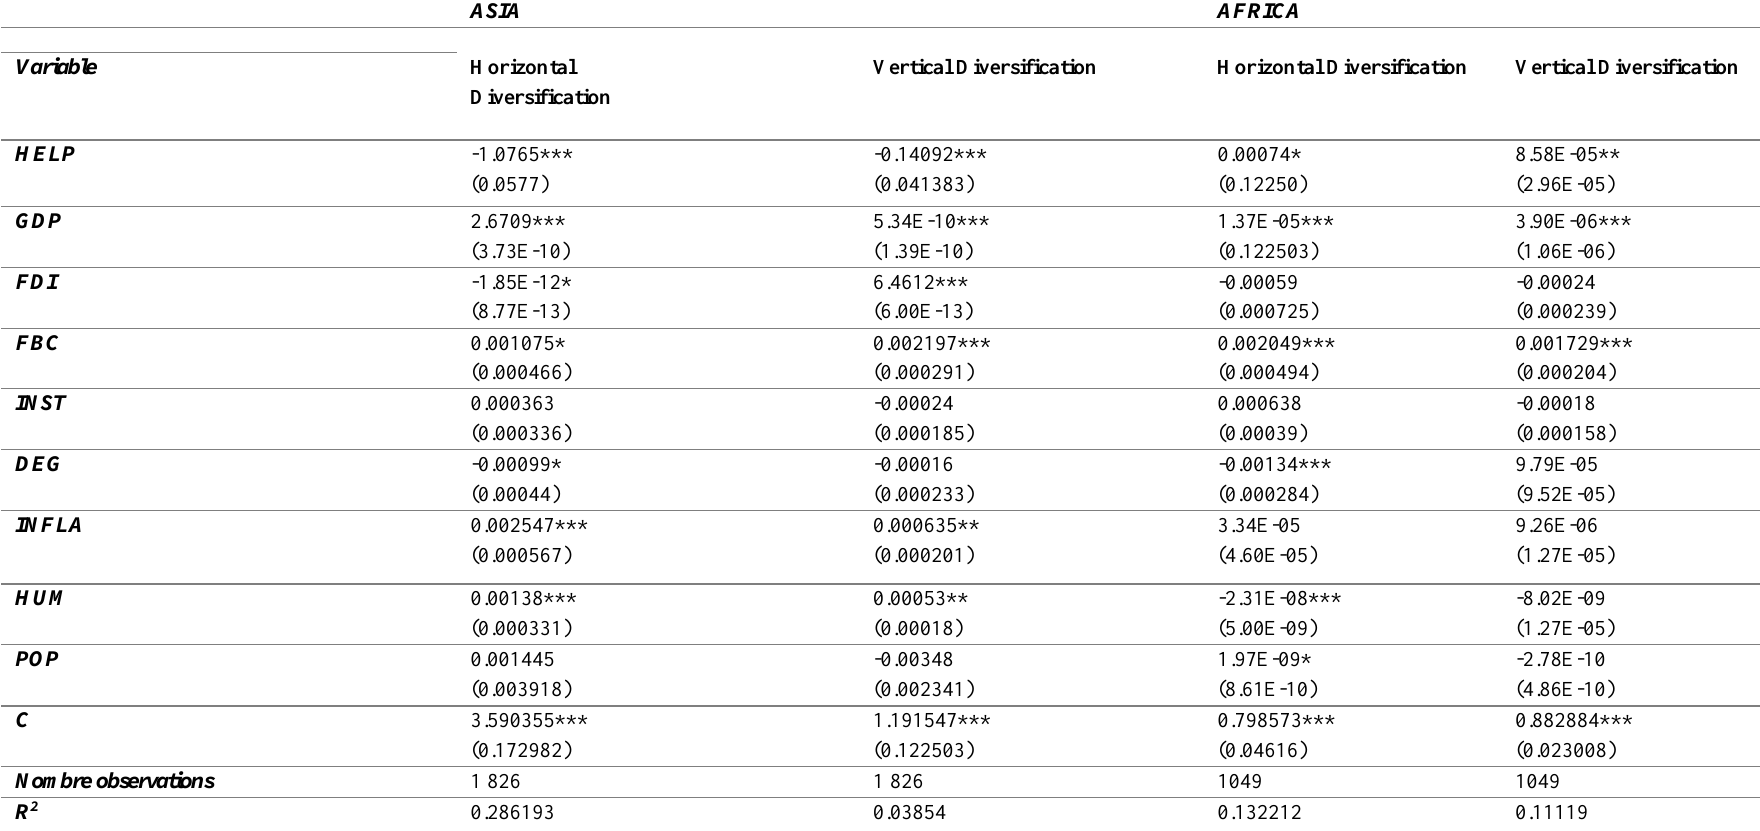
Table 4: Comparison of developing countries in Asia and sub-Saharan